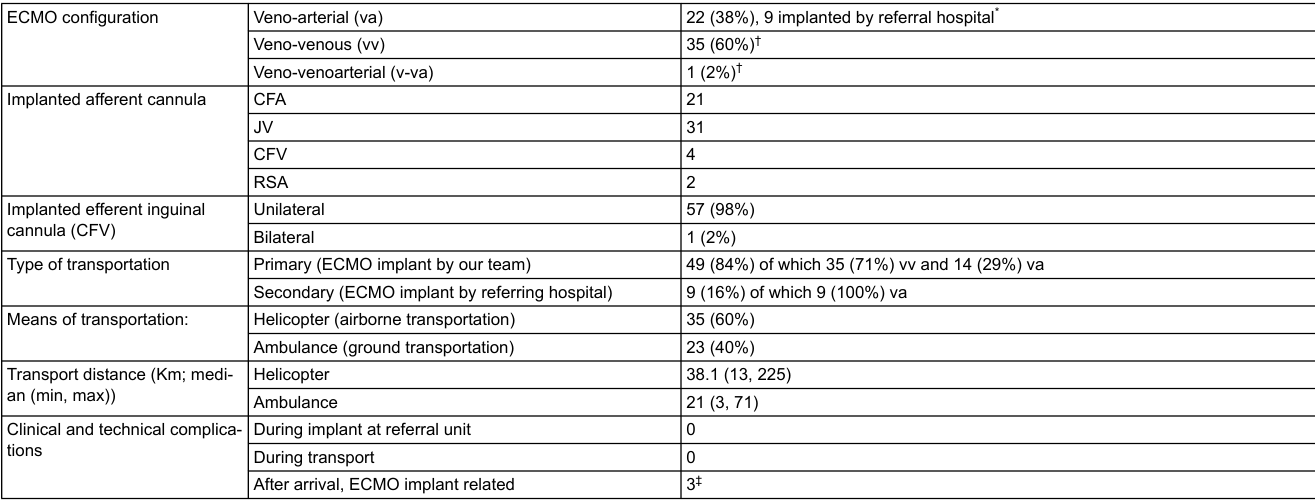
Table 2: ECMO implantation and transportation characteristics. ECMO